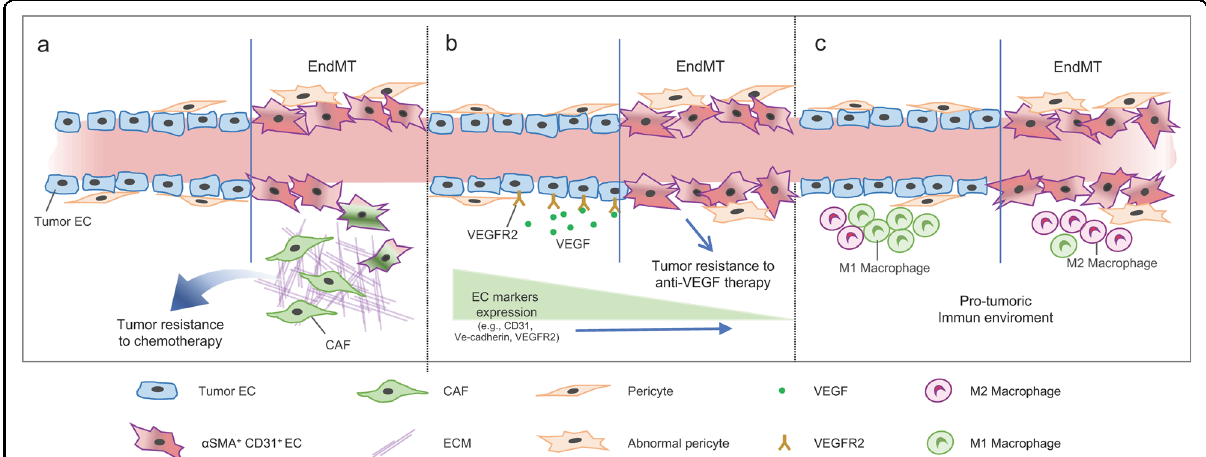
Fig. 2 Schematic illustration of radiation-induced EndMT during radiation therapy in patients with lung cancer. a Radiation-induced lung vascular damage causes the mesenchymal transition of lung ECs, and thus, hypoxic regions formed by damaged vessels enhance the process of tissue fi brosis. Increased HIF- α expression on vascular ECs enhances EndMT via Smad2/3 signaling. b In lung cancer, radioresistant tumors can regrow after radiation therapy. ECs remaining following irradiation undergo EndMT, which increases the tumor burden, and leads to the recruitment of abnormal pericytes. Tumor EndMT promotes tumor regrowth via EndMT-related secreted molecules (such as OPN), and tumor EndMT promotes M2 macrophage polarization of monocytes recruited into the tumor microenvironment after radiation